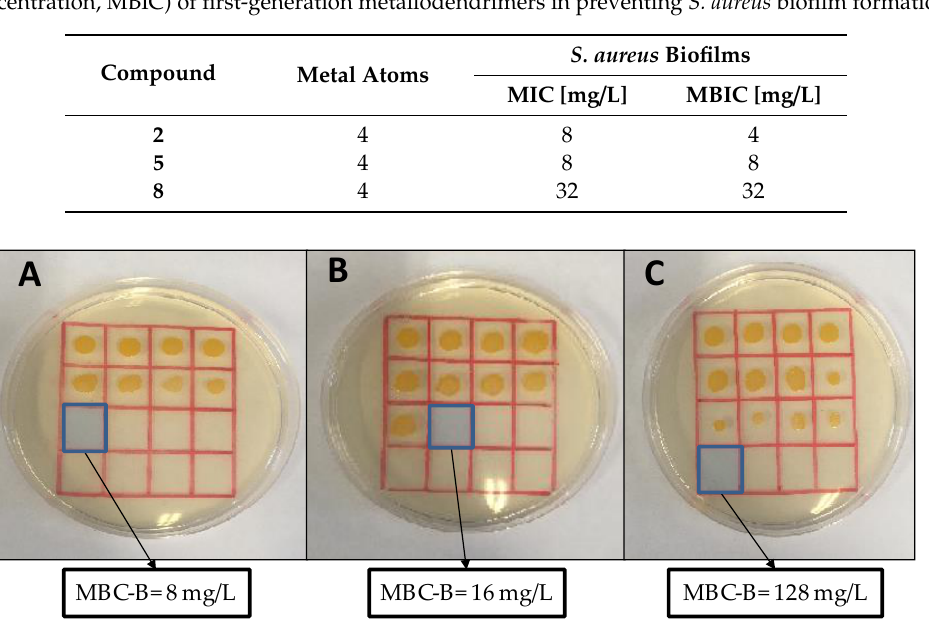
Table 2. Bacteriostatic effect (Minimum Inhibitory Concentration, MIC, and Minimum Biofilm Inhibitory biofilm formation.